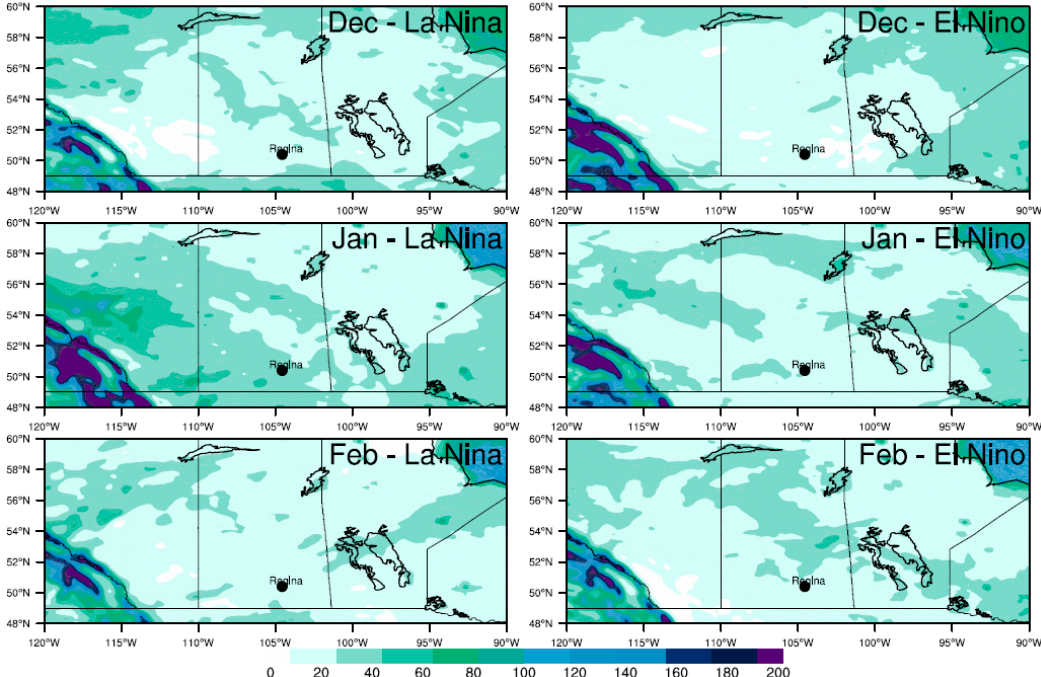
Figure 3. WRF simulated total precipitation (mm) for winter (December, January, and February) during the La Niña of 2010–2011 and El Niño of 2015–2016.